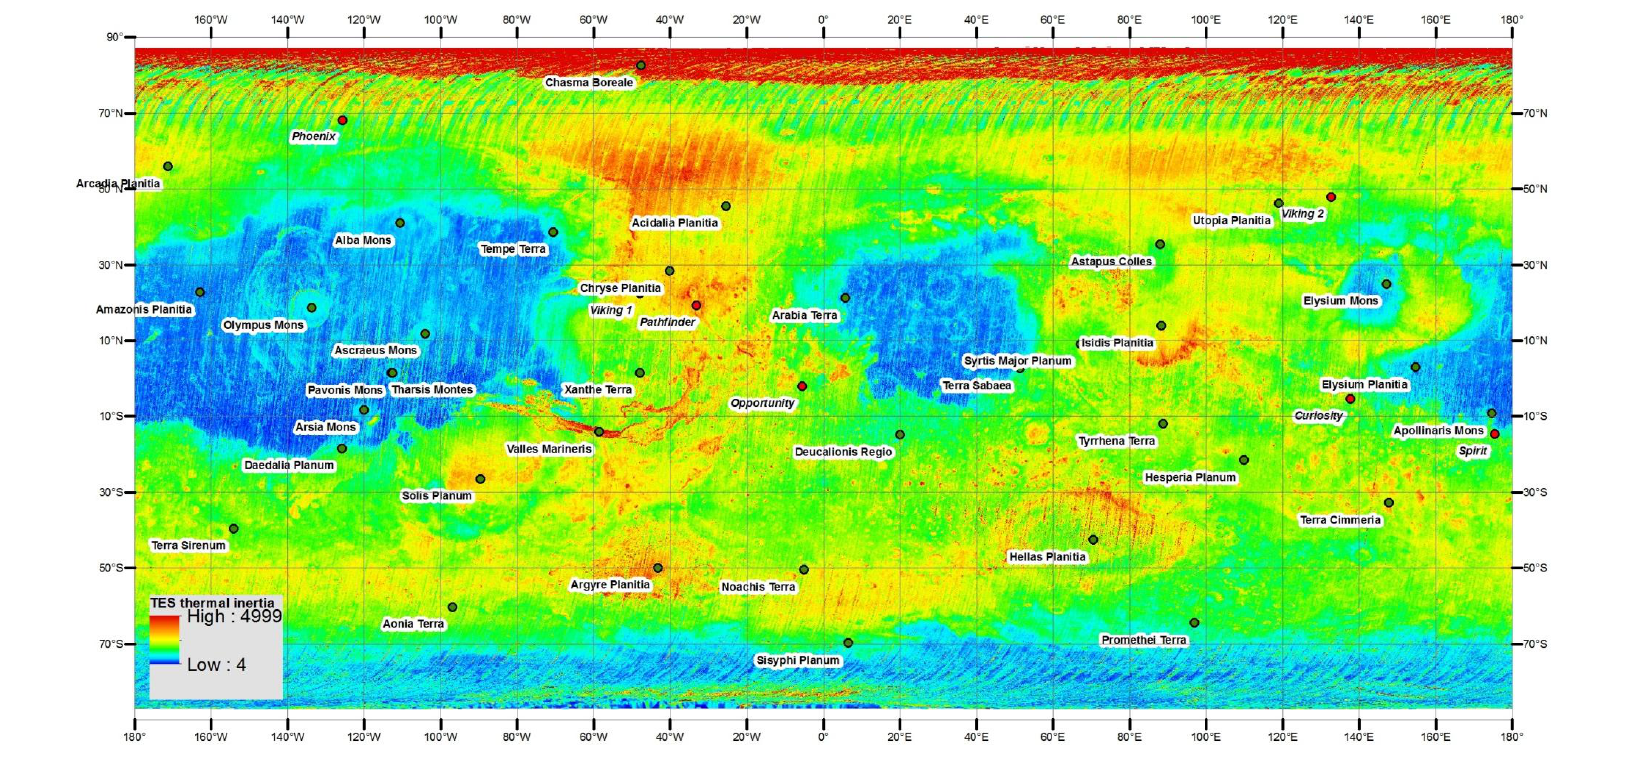
Figure A1. TES thermal inertia data used in this study. Data sourced from